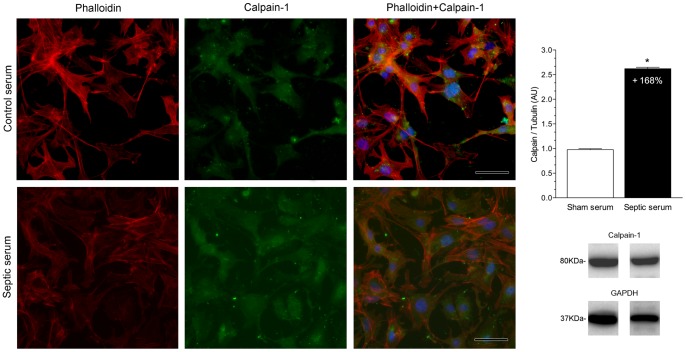
Increased expression and amount of calpain-1 in cultured cardiomyocytes stimulated with septic serum.The fluorescent signal for calpain-1 disclosed increased in cardiomyocytes challenged with serum from septic mice (bottom panel, green fluorescence) in comparison with the fluorescent signal in cardiomyocytes stimulated with serum from sham-operated mice (upper panel, green fluorescence). F-actin was stained with Alexa Fluor 594 dye (red fluorescence) and DNA with DAPI (blue fluorescence). Western blotting demonstrated a strikingly increased, around 168%, of calpain-1 amount in cardiomyocytes stimulated with serum from septic animals compared to cardiomyocytes stimulated with serum from sham-operated mice (*, P<0.01). GAPDH was used as a protein loading control. Data are expressed as mean ± S.D. Scale bars indicate 50 μm.